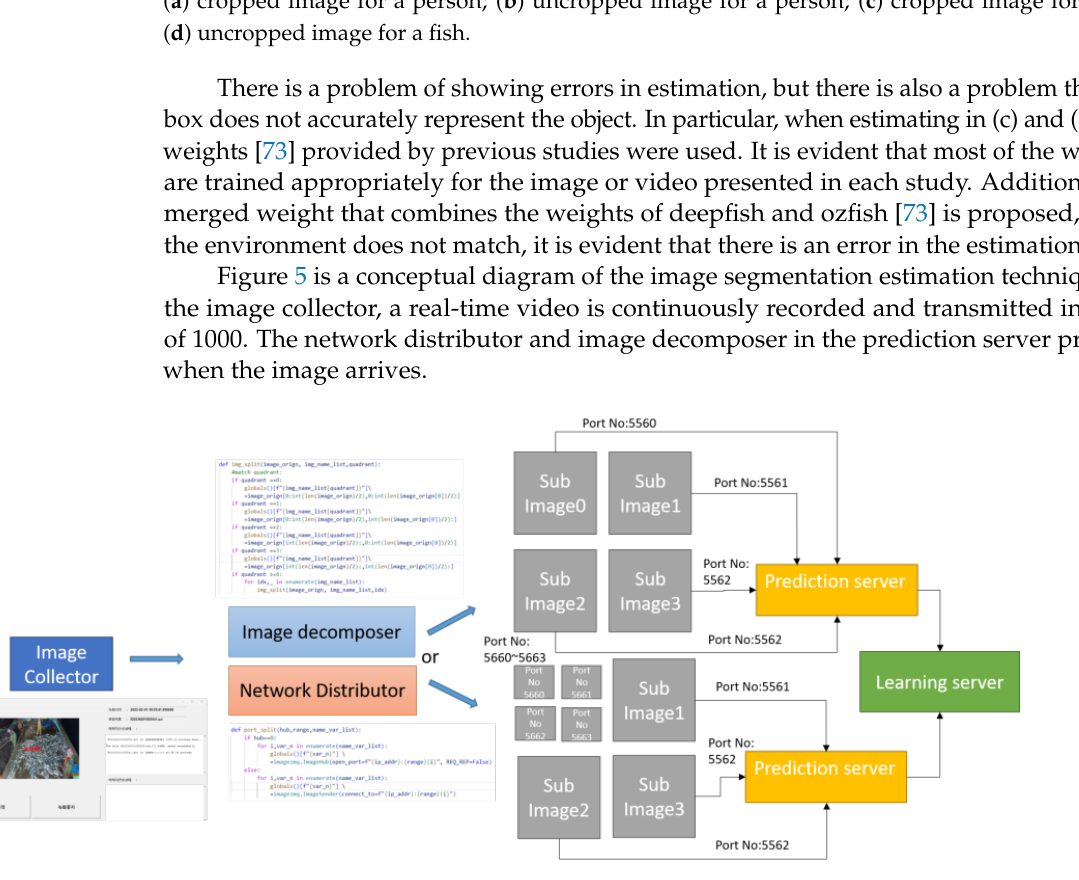
Figure 4. A comparison of predicted images after setting up the cropped and uncropped images: ( a ) cropped image for a person; ( b ) uncropped image for a person; ( c ) cropped image for a fish; ( d ) uncropped image for a fish.